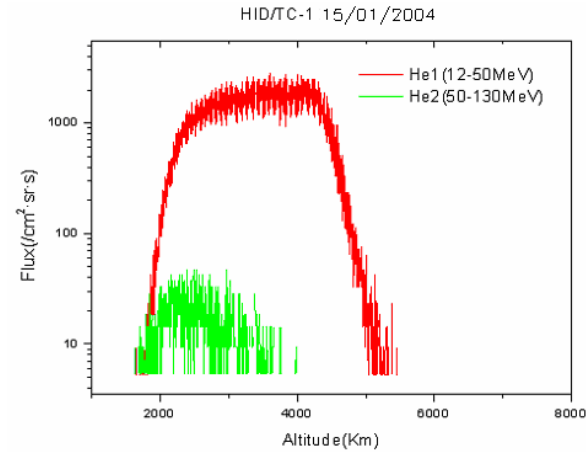
Fig. 11. Flux of Helium ions in energy channels He1 and He2 on 15 January